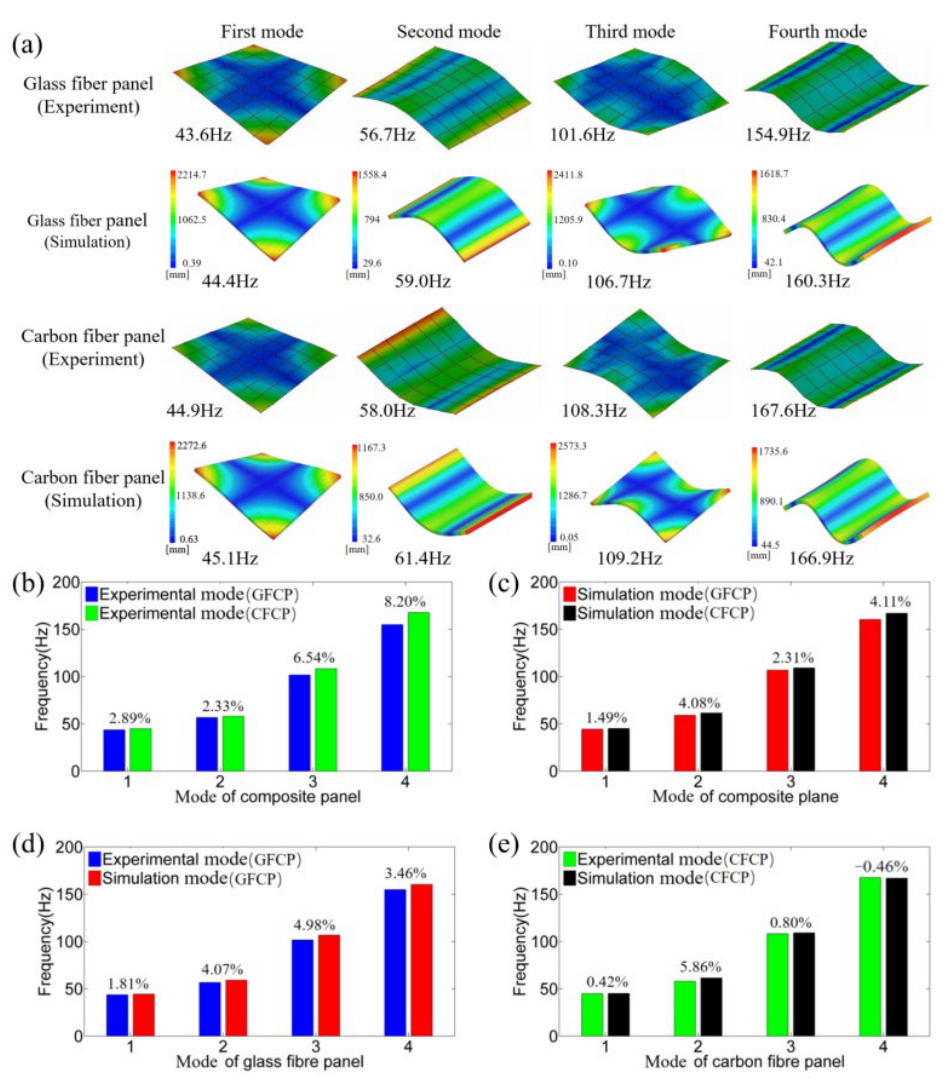
Figure 5. ( a ) Experimental and numerical mode results of the studied GFCPs and CFCPs. ( b ) Comparison of experimental modes of different corrugated panels. ( c ) Comparison of numerical modes of different corrugated panels. ( d ) Comparison of experimental and numerical modes of the GFCPs. ( e ) Comparison of experimental and numerical modes of the CFCPs.